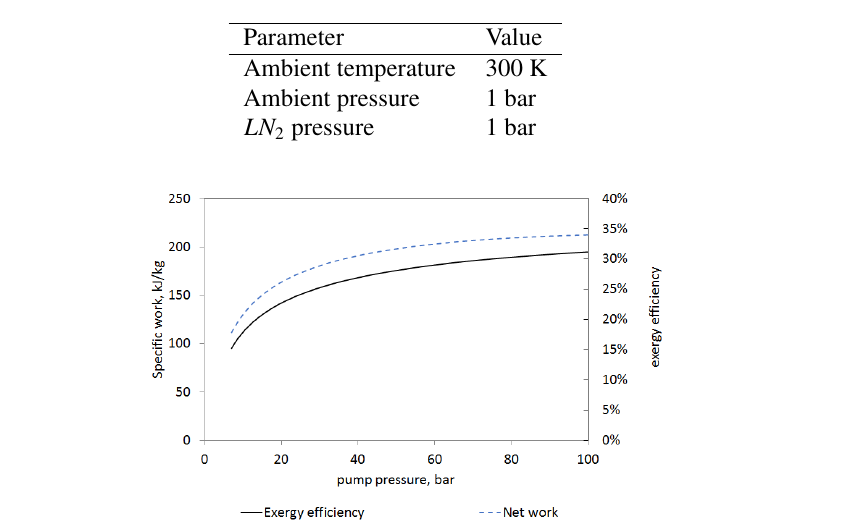
Table 1. Direct expansion cycle parameters